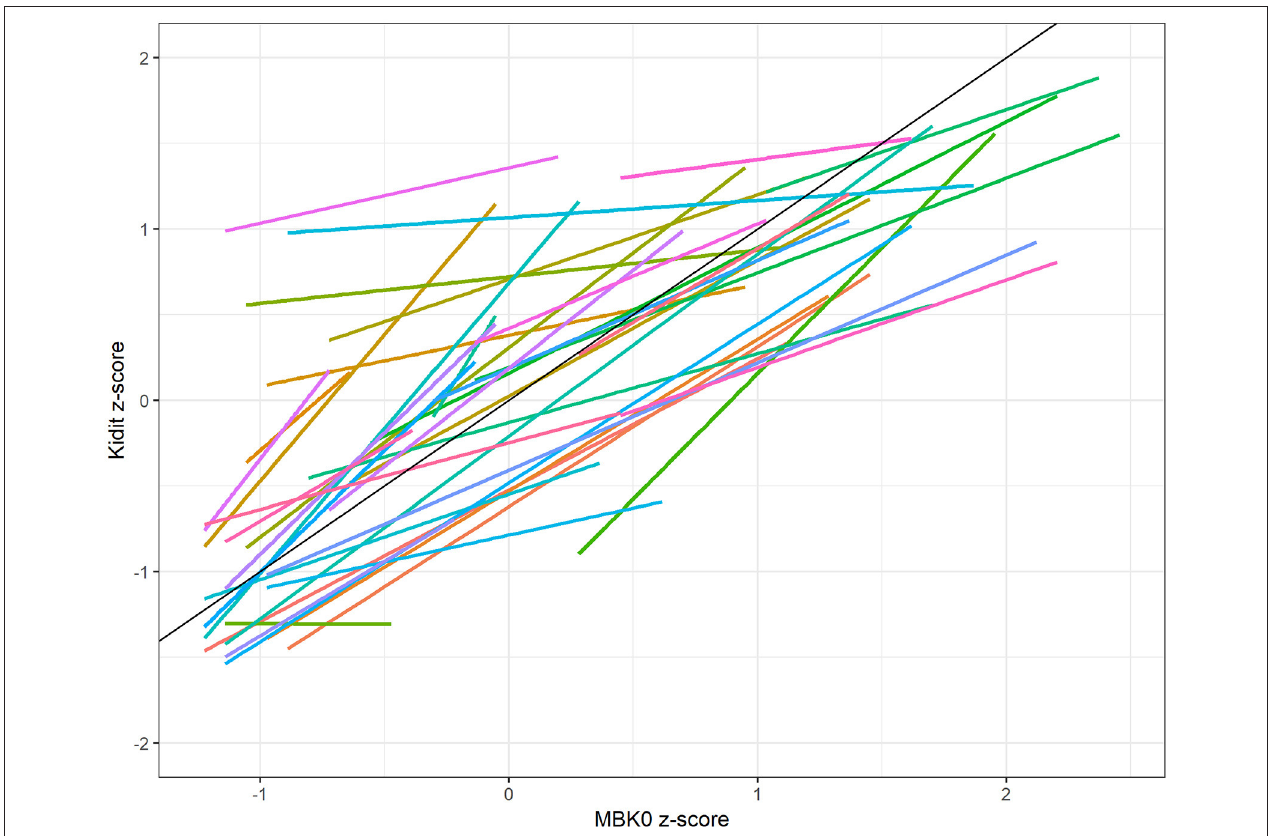
FIGURE 2 | Teacher-specific regression lines (teacher judgment characteristic curves) of KiDiT z -scores of children regressed on MBK-0 z -scores of children. The slim diagonal line with slope 1 and intercept 0 across the plot represents an ideal judgment behavior that is perfectly in accord with the MBK-0 scores. KiDiT, Kinder Diagnose Tool; MBK-0. Mathematische Basiskompetenzen im